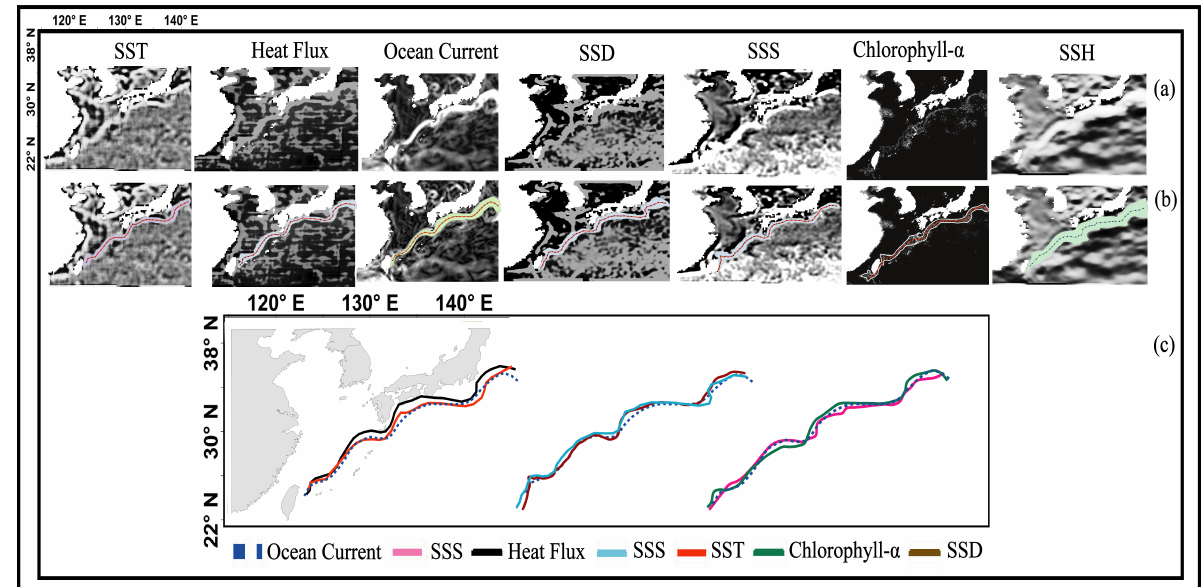
Figure 14. Daily to seasonal scale dispersal of remote sensing ocean parameters during very strong El-Nino between December 2015 to February 2016 ( a ) unveiling of Kuroshio; ( b ) extracted KC extent with centerline; ( c ) comparison of centerline with sea surface current (blue